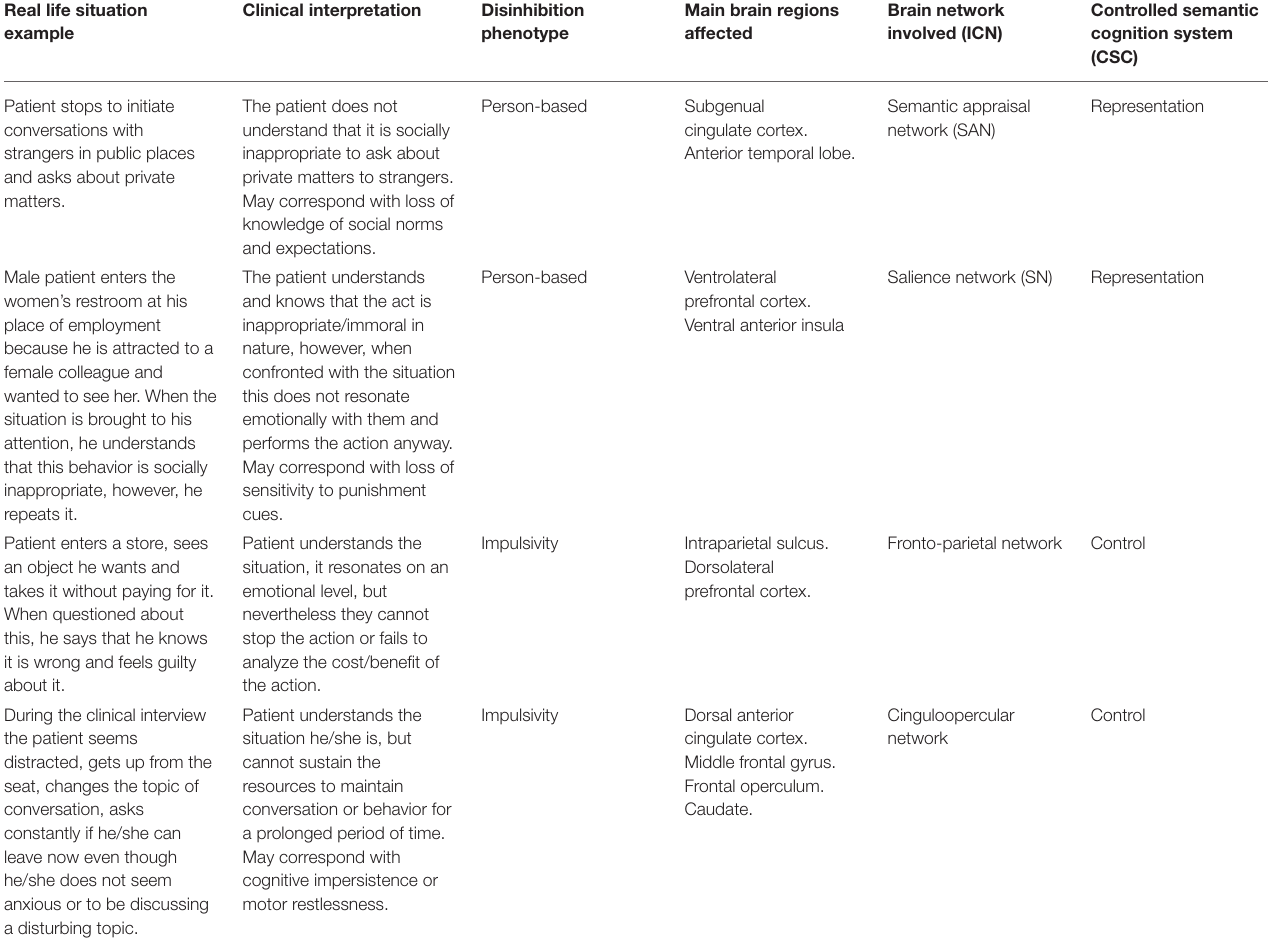
TABLE 1 | Correlation model between clinical scenarios and interpretations of different conceptual